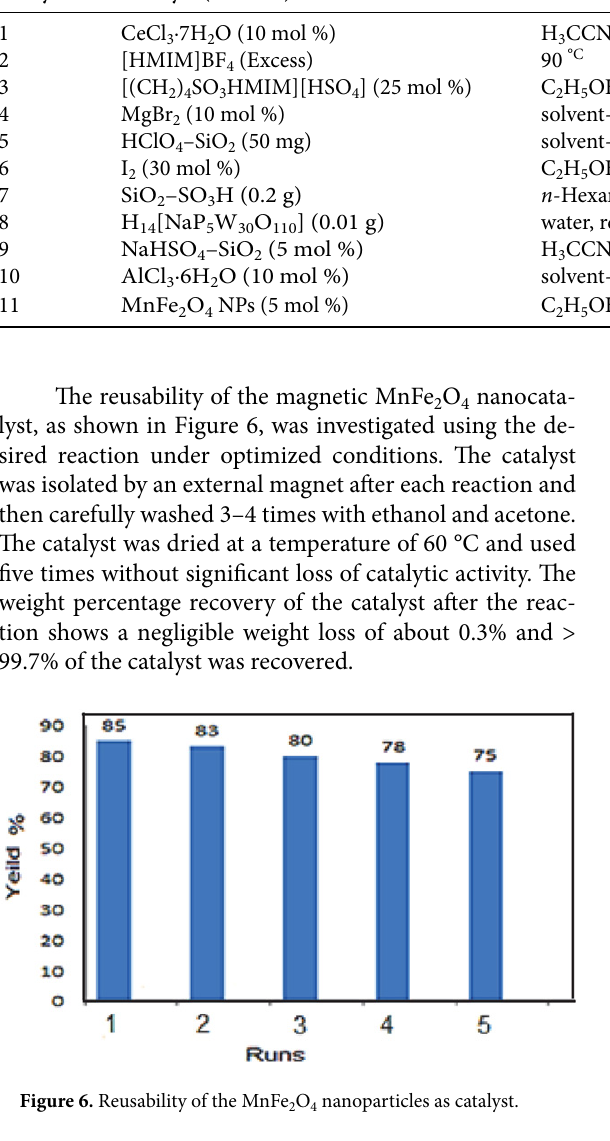
Table 3 . Comparison of the synthesis of 1,4-DHP ( 4b ) using MnFe 2 O 4 NPs with methods described in the literature. Entry Catalyst (amount) Reaction conditions Time